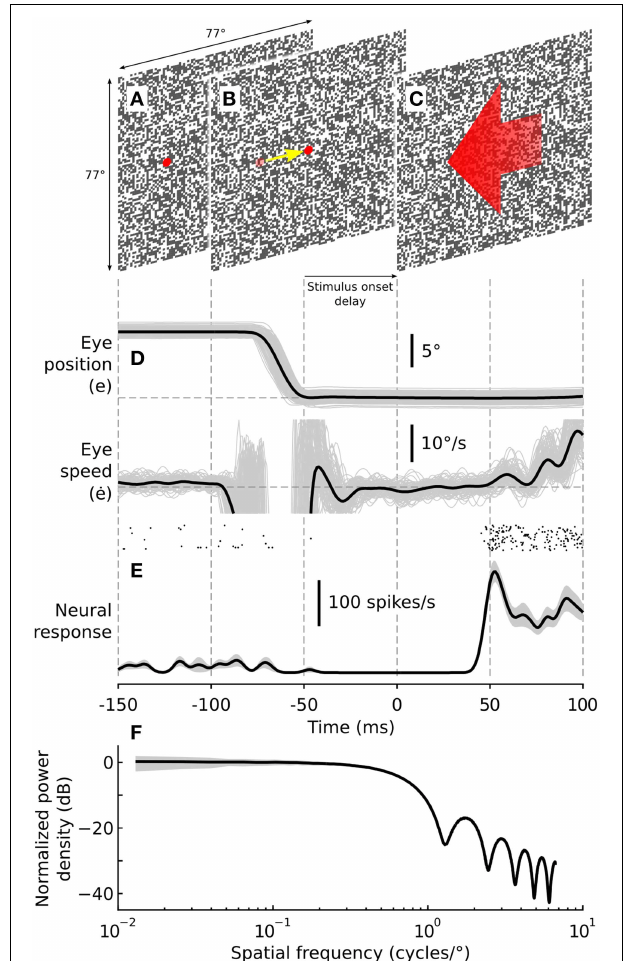
FIGURE 1 | Experimental methodology. Visual stimuli consisted of a random checkerboard texture, 77 ◦ × 77 ◦ with a check size of 0.8 ◦ × 0.8 ◦ . Monkeys made rewarded saccades from a peripherally presented target (A) to a centrally presented target (B) . After the centering saccade the monkeys were required to maintain fixation for a nominal period of either 50 (short-delay condition) or 300ms (long-delay condition) after which the background texture began moving (C) , eliciting robust spiking responses and triggering reflexive ocular following. The post-saccadic test stimulus always moved in the preferred direction (opposite to that of the saccade) and at the preferred speed of the recorded cell. Peri-saccadic stimuli were presented at 100% contrast, and for some cells, at 0% contrast to determine the effect of visual stimulation during the saccade on the observed post-saccadic enhancement. Post-saccadic motion stimuli were always presented at 100% contrast. (D) Eye movements were recorded using scleral search coils implanted in both eyes. Eye speed of the reflexive ocular following response was calculated off-line, providing a behavioral assay for post-saccadic enhancement. Thin gray lines show eye position and speed for individual trials. The black lines show representative eye position and speed signals averaged across all trials. (E) Spiking activity was recorded from visual neurons in the dorsal part of the medial superior temporal area (MSTd). The raster plot shows spike arrival times from a representative neuron for all trials ( n = 20 ). The black line shows the mean spike density function while the shaded region shows ± 1 SE. (F) Normalized orientation averaged power spectrum of the post-saccadic test stimulus. The black line shows the power spectrum averaged over 1000 random texture samples, normalized to the mean power at 0.1 cycles/ ◦ . The